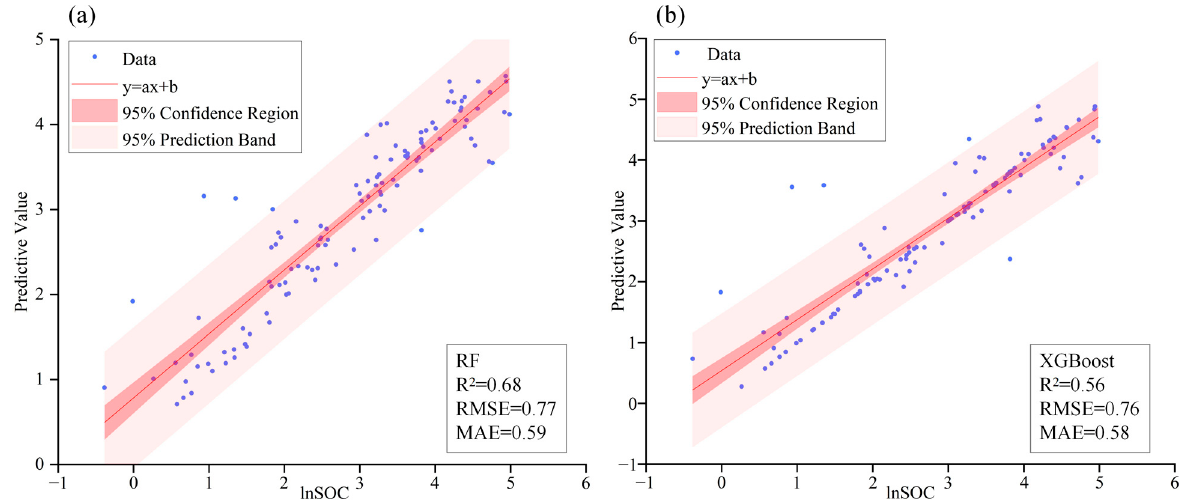
Figure 6. Model fitting result by RF ( a ) and XGBoost ( b ) when phenological variables and normal variables were used.